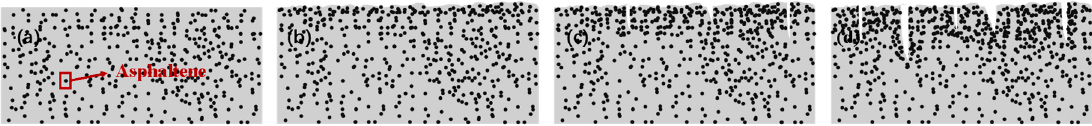
Figure 9. The four stages of asphalt binder base topography change under UV radiation: ( a ) The asphalt binder surface is smooth and flat, ( b ) the asphalt binder surface is wrinkled, ( c ) micro-cracks occur in the asphalt binder surface, and ( d ) the cracks are further extended and expanded to be wider and deeper.